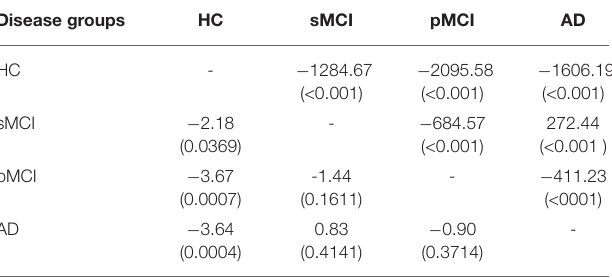
TABLE 4 | Group comparisons of brain-age in OASIS3